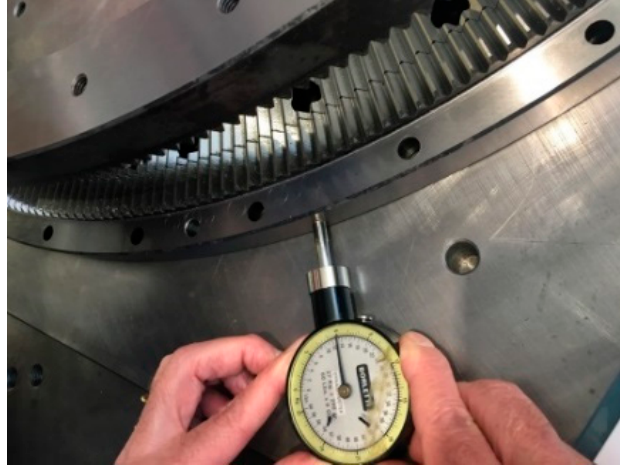
Figure 12. Self-centering capability with the presence of R μ and F r,e . Table 4. Experimental verification of the self-centering capability.